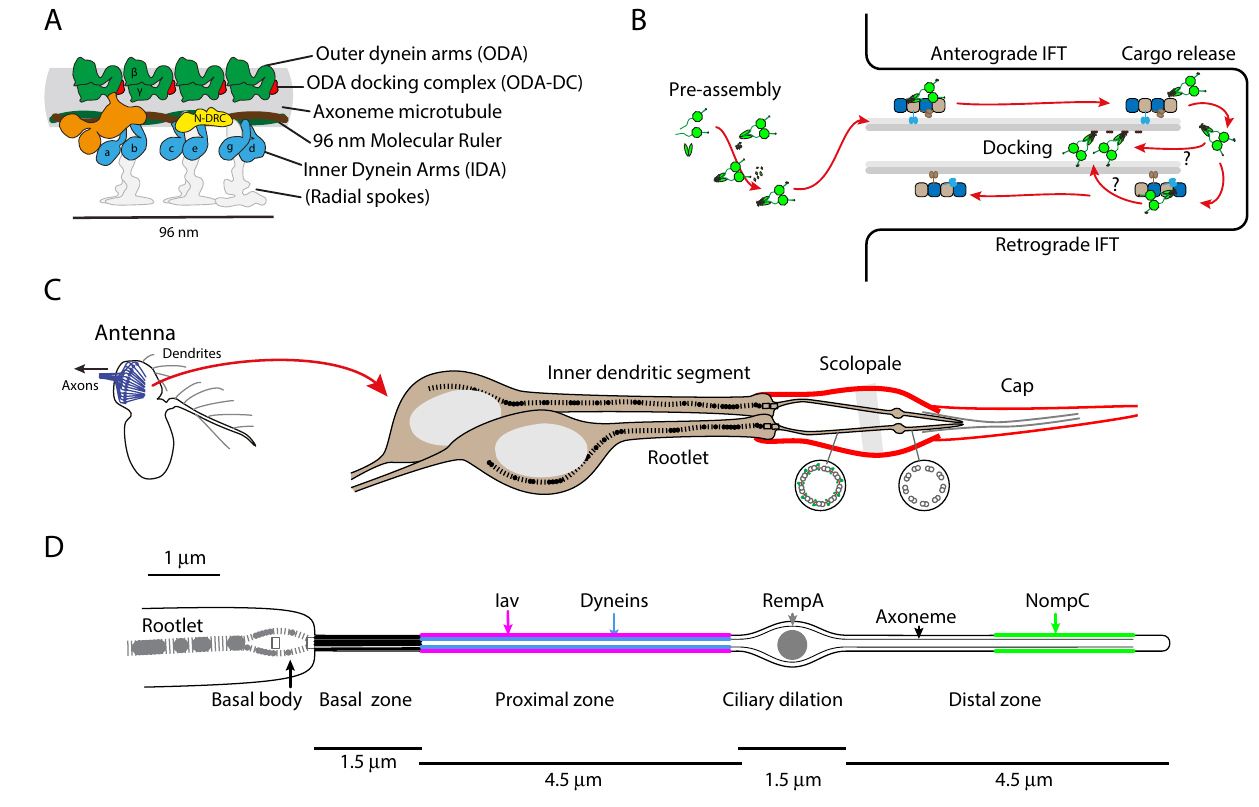
Figure 1. Axonemal dyneins and the chordotonal neuron cilium. ( A ) Schematic of the axonemal protein complexes of motile cilia. The repeating unit of a single microtubule doublet is represented. Chordotonal cilia have a 9 + 0 axoneme and so lack the radial spokes (greyed out). N-DRC: nexin-dynein regulatory complex. Based on 14 . ( B ) Schematic outline of generalised axonemal dynein assembly and the intraflagellar transport (IFT) pathway. ( C ) The structure of chordotonal scolopidia of Johnston’s organ (JO) in the Drosophila antenna. JO is housed in the second antennal segment. Each ‘unit scolopidium’ comprises 2–3 mechanosensory chordotonal neurons. Each dendrite terminates in single 9 + 0 cilium. The cilia are bathed in lymph within a scolopale structure and are attached at their tips to a cap structure, enabling the transmission of mechanical force to the cilia. ( D ) Schematic of the adult chordotonal neuron cilium (outer dendritic segment). The cilium is divided into a ‘motile’ proximal zone and a ‘sensory’ distal zone, between which is the ciliary dilation (CD). Axonemal dyneins and TRPV channels (Iav/Nan) are confined to the proximal zone whereas TRPN channels (NompC) are in a region of the distal zone. Several proteins reside at the ciliary dilation, including the IFT-A protein, RempA. Lengths are approximate, based on electron micrographs of adult JO